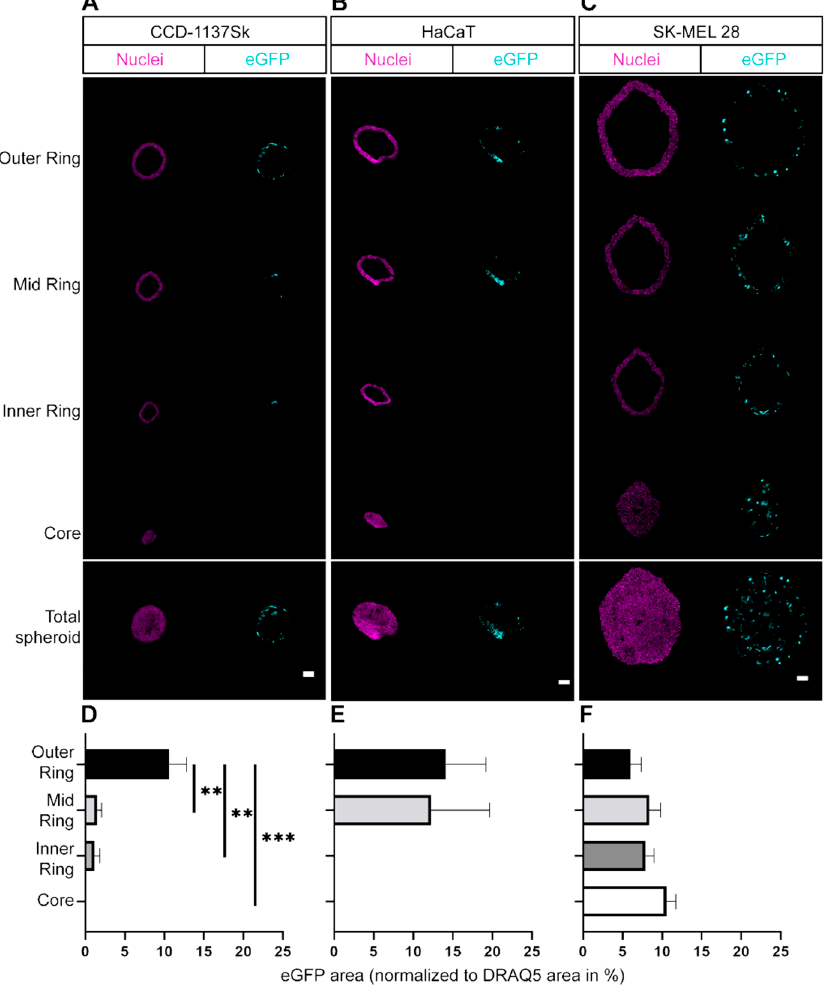
Figure 4. Differential distribution of eGFP-signals is observed in LPX-transfected 3D monoculture spheroids. For each spheroid, a total of 1 × 10 4 cells were seeded and transfected with 10 ng/µL eGFP LPX. Spheroids were fixed and stained for nuclei. Confocal microscopy was used to visualize nuclei (magenta) and eGFP (cyan). ( A – C ) Representative confocal images of the spheroid segments (i.e., outer ring, mid ring, inner ring, and core) of single optical sections taken in the spheroid center (Total spheroid). Scale bars, 100 µ m. ( D – F ) Quantitative analyses of eGFP area normalized to nuclei area for each segment of CCD-1137Sk ( D ), HaCaT ( E ), and SK-MEL 28 cells ( F ). Mean + SD ( n = 3 independent experiments, at least 3 spheroids per condition). One-way ANOVA with Tukey’s multiple